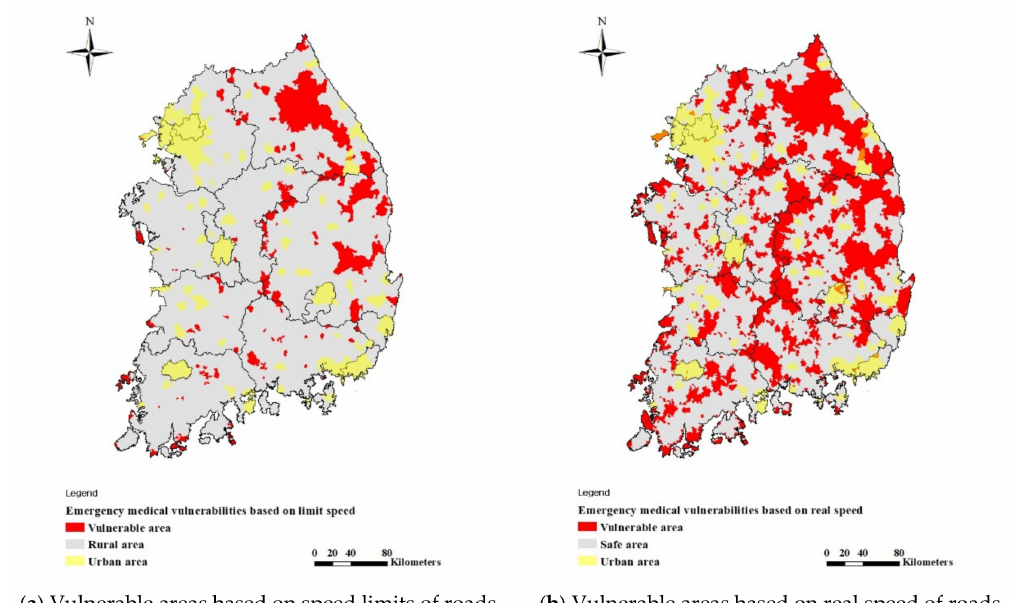
Figure 4. Vulnerable areas depending on the road tra ffi c flow speed. The yellow and gray areas indicate urban and rural areas, respectively. The red areas indicate vulnerable areas of EMS, where an emergency patient could not arrive at an emergency medical center within 30 min. ( a ) shows 659 vulnerable areas (4 urban areas and 655 rural areas). ( b ) shows 3618 vulnerable areas (48 urban areas and 3570 rural